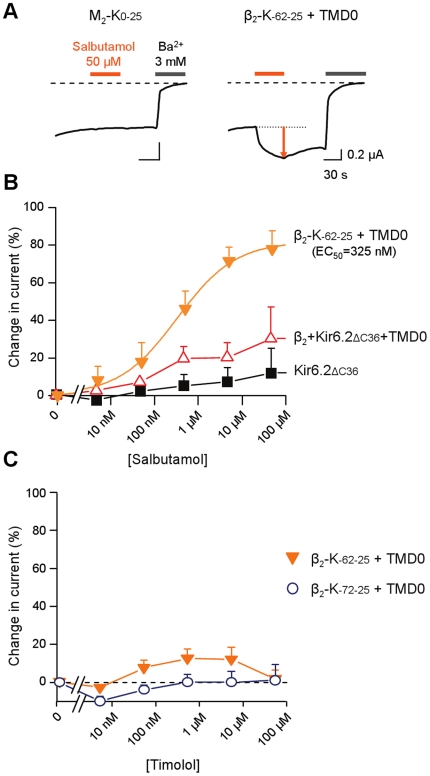
Effect of a β2AR partial agonist on β2-K-62-25.Concentration-effect curves for salbutamol measured in oocytes co-expressing the indicated proteins. Values are average of 3-7 measurements. The smooth line is a Hill equation fit to the β2-K-62-25+TMD0 data with EC50  =  452 nM and h = 0.6. Data obtained with the unfused Kir6.2 as a control could not be fitted.